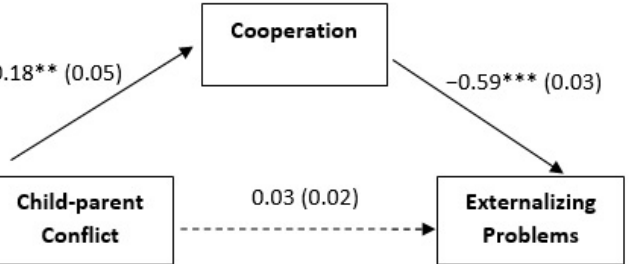
Figure 1. Cooperation as mediator of the association between Child–parent Conflict and External- izing Problems. Unstandardized coefficients are reported with standard errors in parentheses. The model includes Gender as a covariate of both Cooperation and Externalizing Symptoms. Analyses were based on 5000 bootstrap samples with 95% bias-corrected confidence intervals; ** p < 0.01; *** p < 0.001.